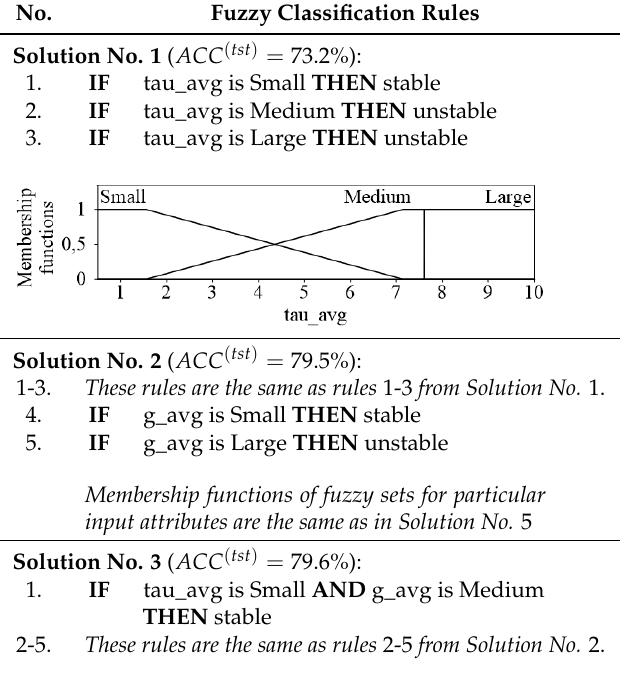
Table 8. Fuzzy rule bases for SPEA3-based solutions (FRBCs) 1–3 from Figure 5. No. Fuzzy Classification